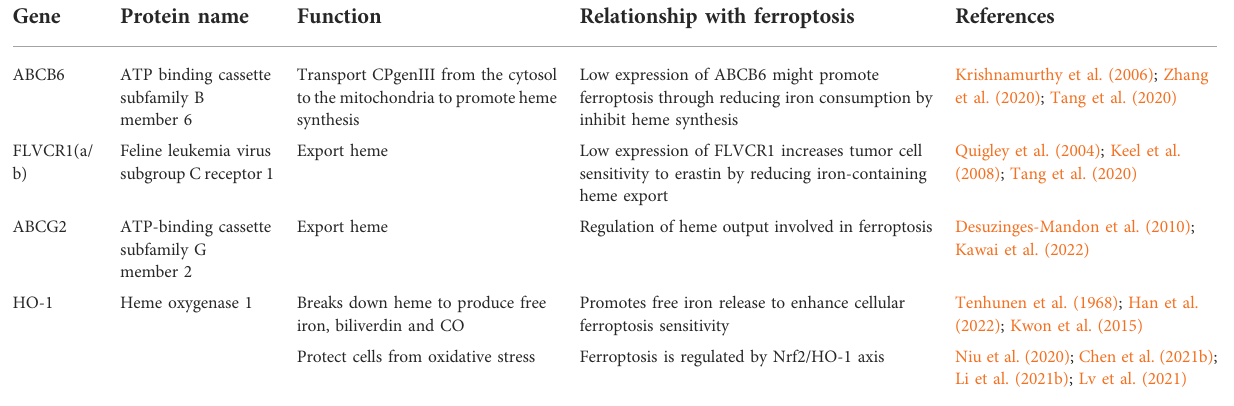
TABLE 1 Heme metabolism related genes and